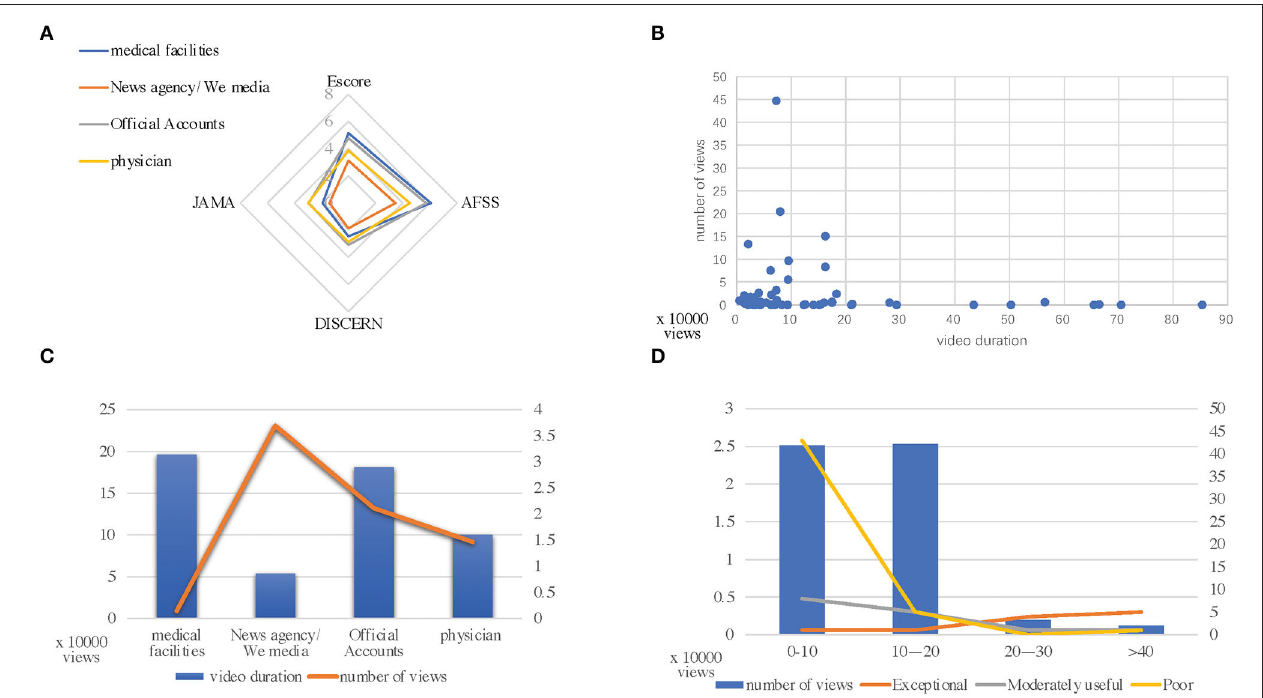
TABLE 5 | Objective data values categorized by video publisher type on YouTube.